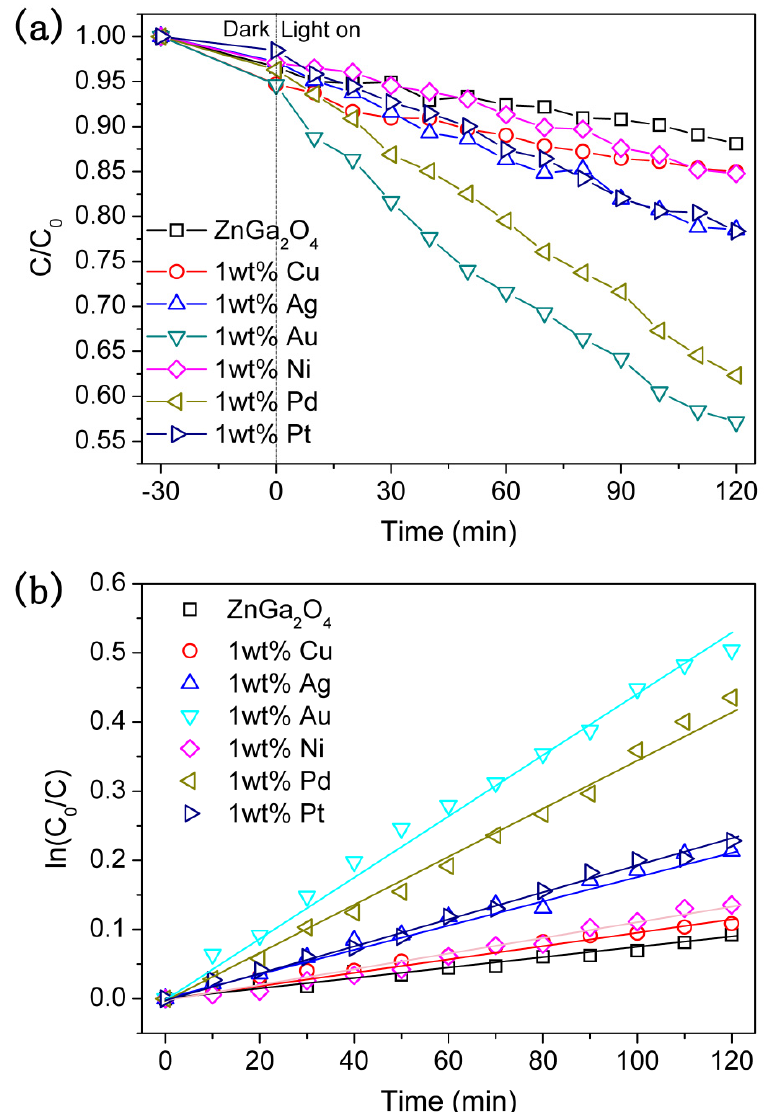
Figure 4. ( a ) The photocatalytic degradation activities of ZnGa 2 O 4 with different cocatalysts plotted against time; ( b ) the kinetic constants of photocatalytic degradation of rhodamine B (RhB). Photocatalytic conditions were: 0.1000 g of photocatalyst, 300 mL of 13.3 ppm RhB solution, 300 W Hg-lamp.